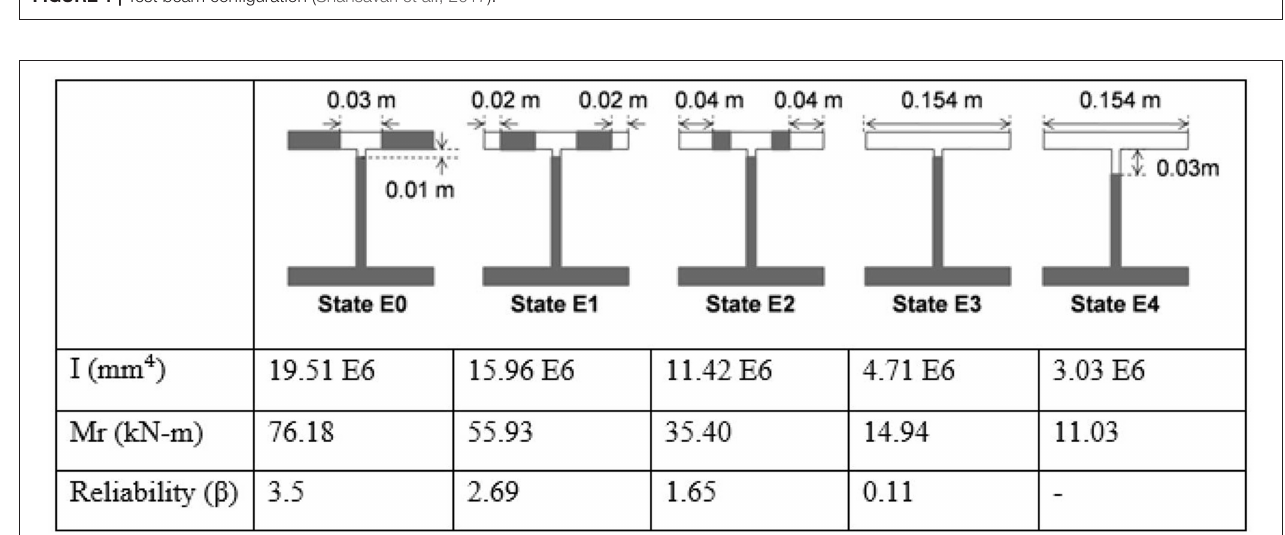
345 MPa) (Shahsavari, 2017). =